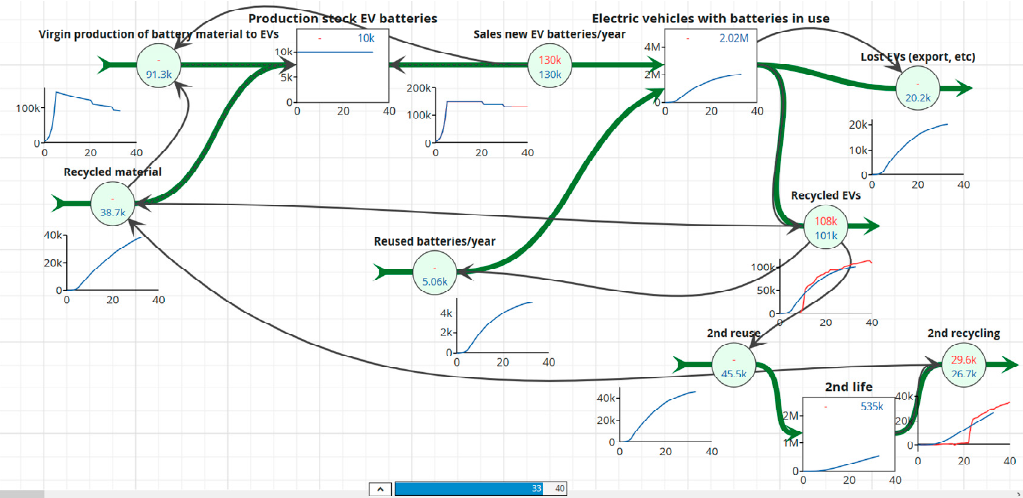
Figure 5. Example of a basic stock and flow system dynamics model with relations of stocks and flows.